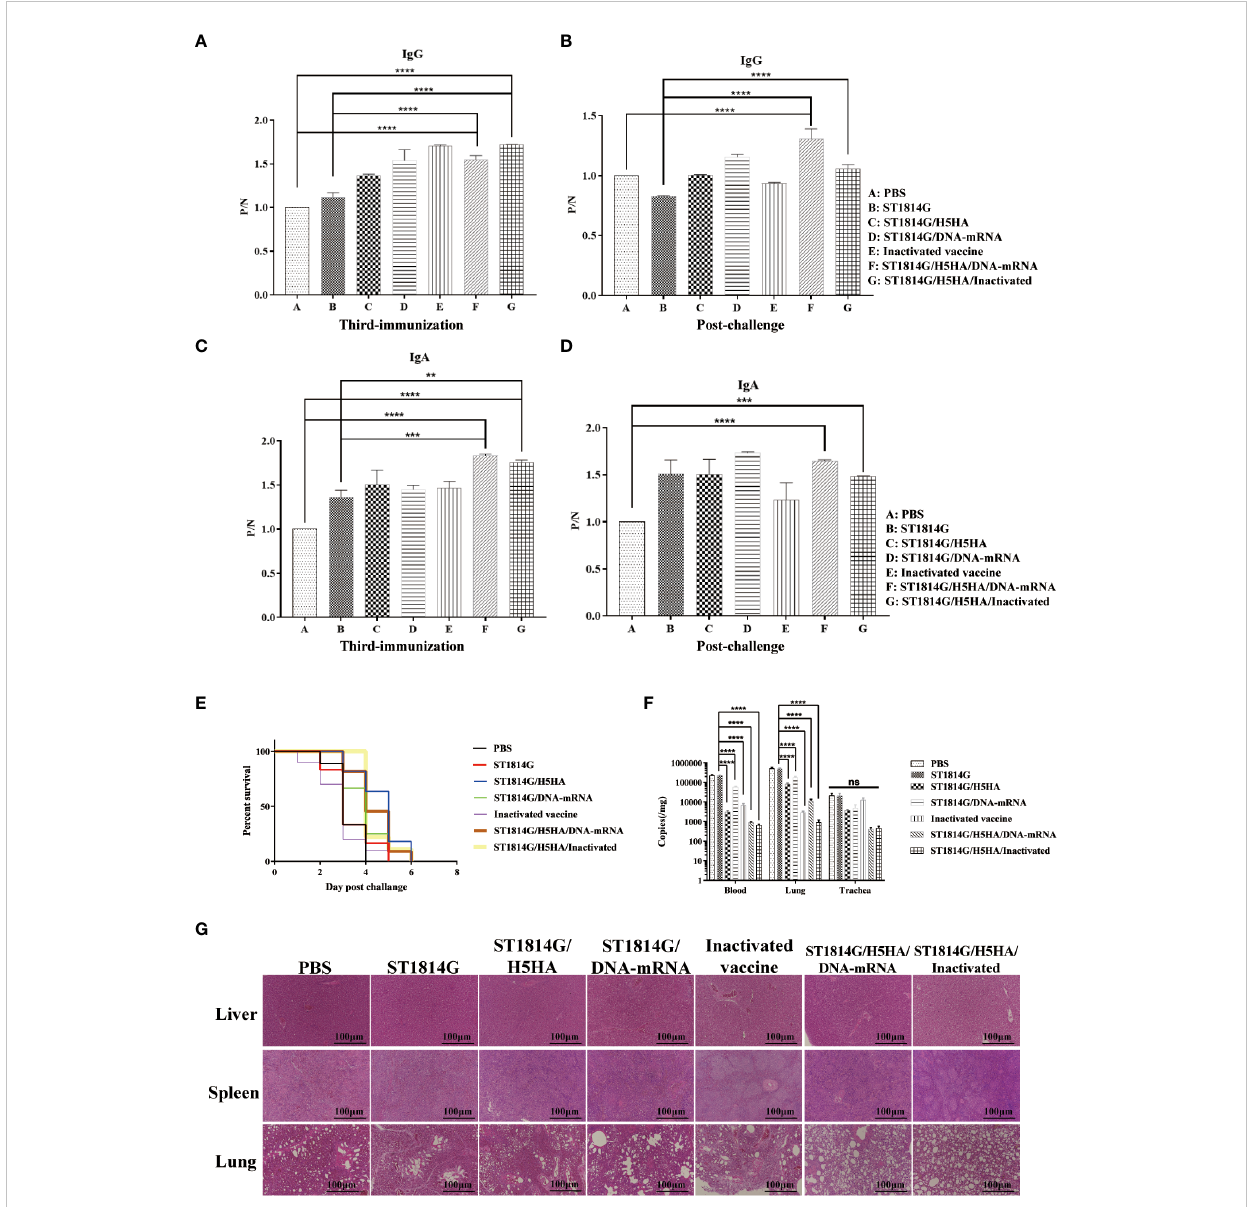
FIGURE 2 Protective effects of engineered yeast vaccine. (A – D) The level of both the secreted IgA in anal swabs and the IgG in serum of each group. The signi fi cance of differences was determined by two-way analysis of variance. (A, C) , samples after the third immunizations; (B, D) , samples post challenge), (**p < 0.01; ***p < 0.001; ****p < 0.001). (E) Survival rate of each group at the indicated time post infection. (F) Virus titer determination of each group in the blood and lung. Statistical analysis was analyzed by Student ’ s t-test. (****p < 0.001 n=3 chickens for each group). (G)